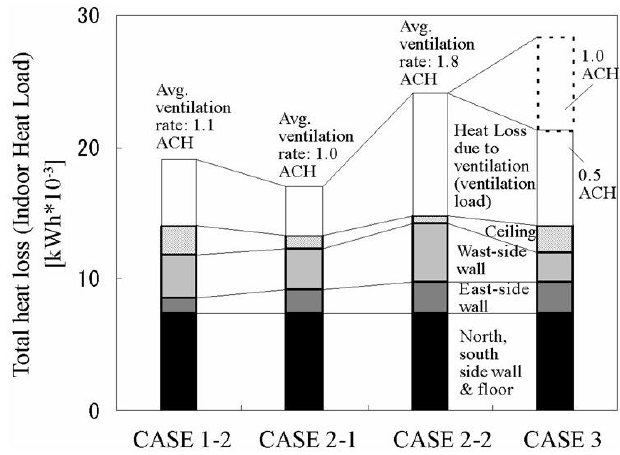
Figure 12. Total heat load between Dec. and Feb.